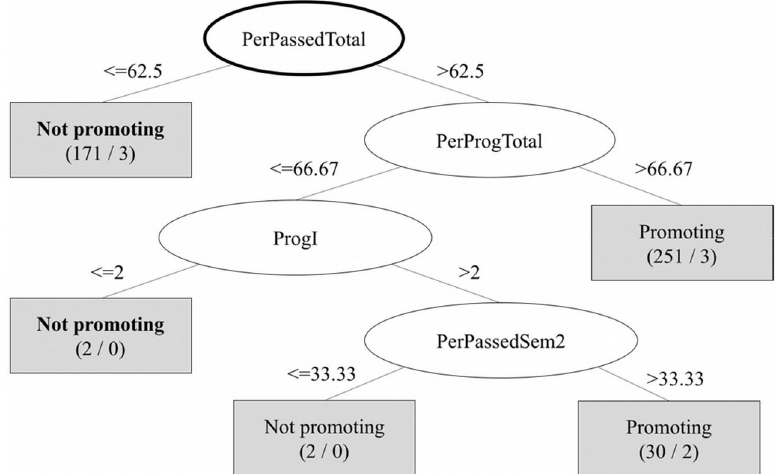
Figure 1. Decision tree corresponding to all features